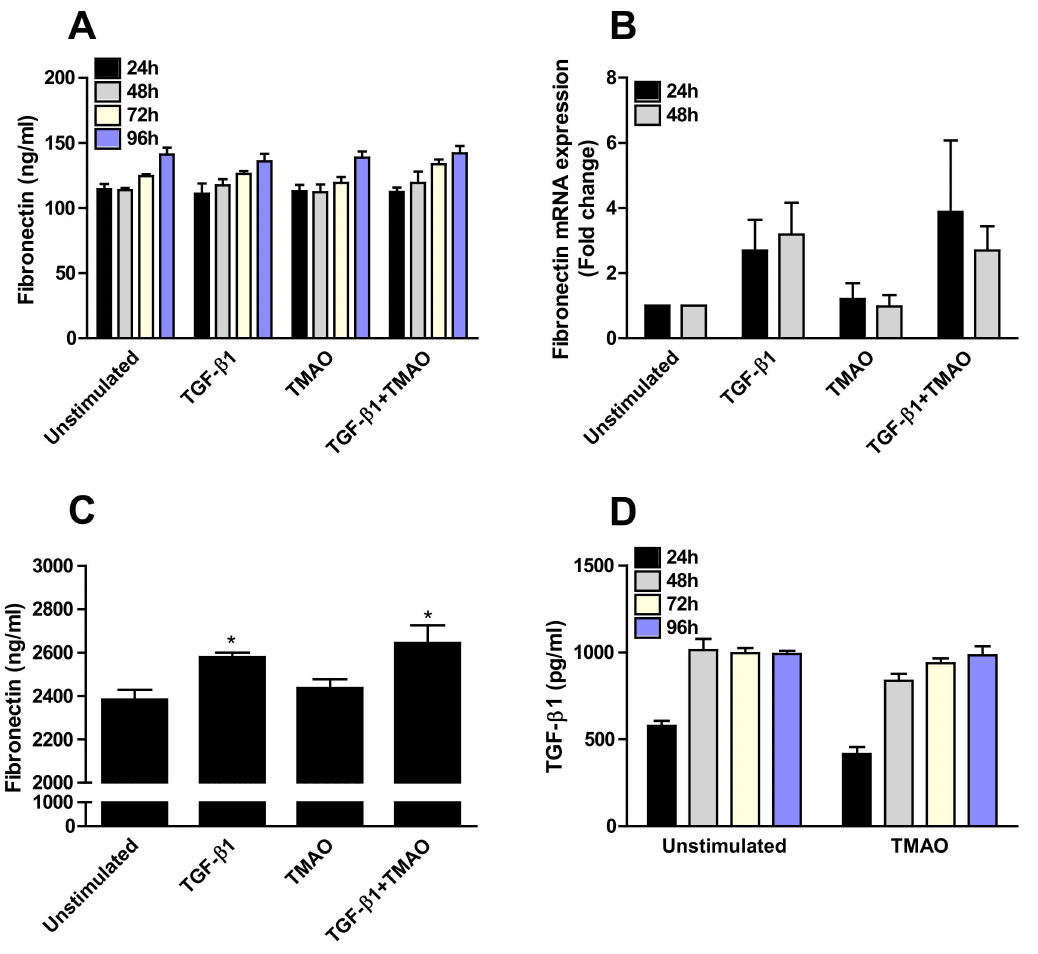
Figure 5. TMAO stimulation does not induce fibronectin or TGF- β 1 production from renal fibroblasts. Renal fibroblasts were stimulated with 300 µ M TMAO and 10 ng/mL TGF- β 1 for 24 h ( A , B , D ), 48 h ( A , B , D ), 72 h ( A , D ) or 96 h ( A , C , D ) and fibronectin release ( A , C ) fibronectin gene expression ( B ) and TGF- β 1 release ( D ) were evaluated. Fibronectin levels in supernatants in combination with cell lysates were also evaluated ( C ). Data are presented as mean ± SEM ( n = 3 independent experiments). Asterisks denote statistical significance compared to unstimulated cells (* p <